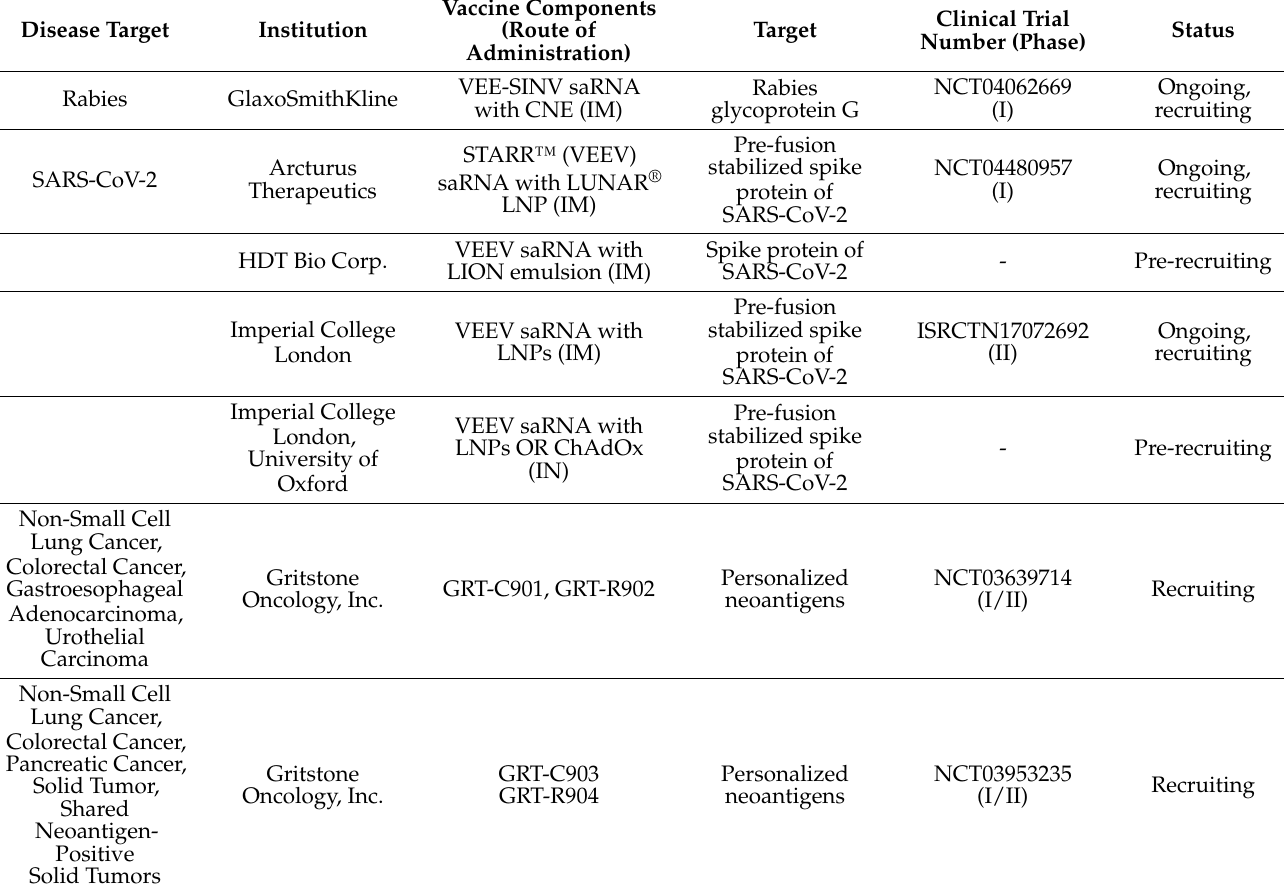
Table 3. Clinical trials of saRNA vaccines since